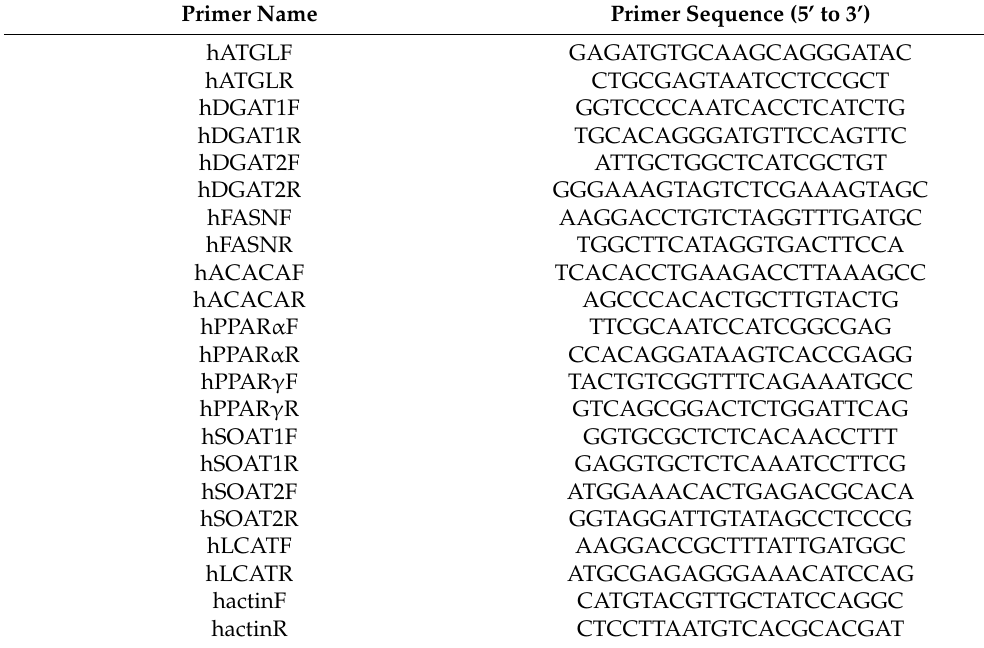
Table 1. Primers used in qPCR